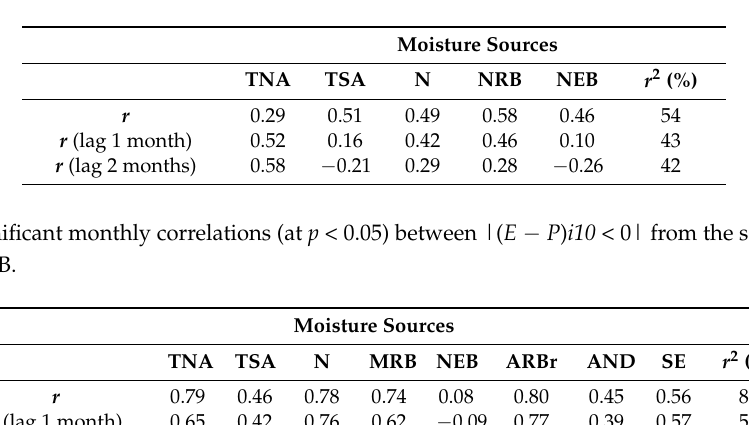
Figure 7. Precipitation (grey bars) and moisture contribution to annual precipitation (|(E − P)i10 < 0 |) cycles in the NRB ( a ) and MRB ( b ). Period: 1980–2016. Table 2. Significant monthly correlations (at p < 0.05) between | (E − P)i10 < 0| from the sources and P over the NRB.